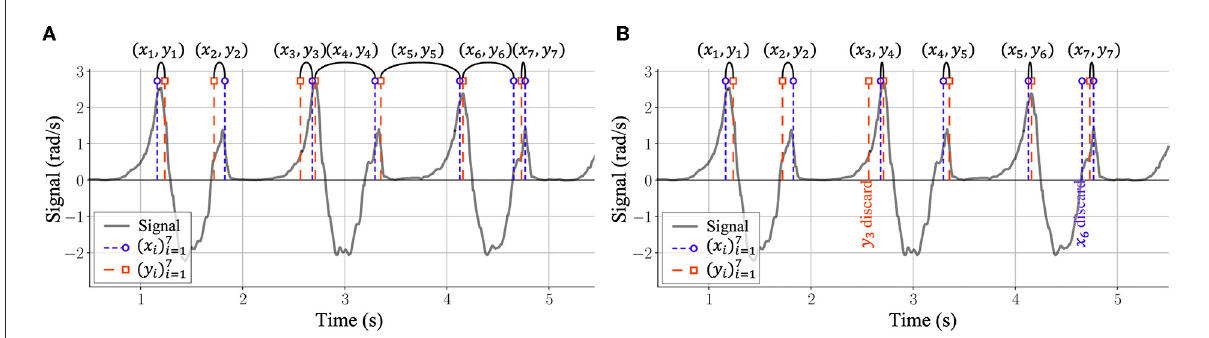
FIGURE2 The illustration of matching algorithm for manual labeling of motion capture data. Given two label sequences ( x i ) 7 i = 1 and ( y j ) 7 j = 1 from two labelers containing the same number of labels, it is demanded to find the best sequence of index pairs ( i , j ), associating elements of x i to elements of y j such that one can then proceed in computing the error between sequences ( x i ) 7 i = 1 and ( y j ) 7 j = 1 . (A) An example of matching results of two label sequences according to their index. It can be seen that the resulting fourth, fifth, and sixth pairs of labels ( x 4 , y 4 ), ( x 5 , y 5 ), and ( x 6 , y 6 ) do not correspond to the same gait events. (B) An illustration of NWA algorithm for matching labels from different human labelers. With NWA, gait event labels are matched according to their relative distances and two labels, namely y 3 and x 6 , are considered as outliers and discarded in the further human error computation. The reasons for the existence of such outliers include human labeling errors as well as the errors from the automatic labeling